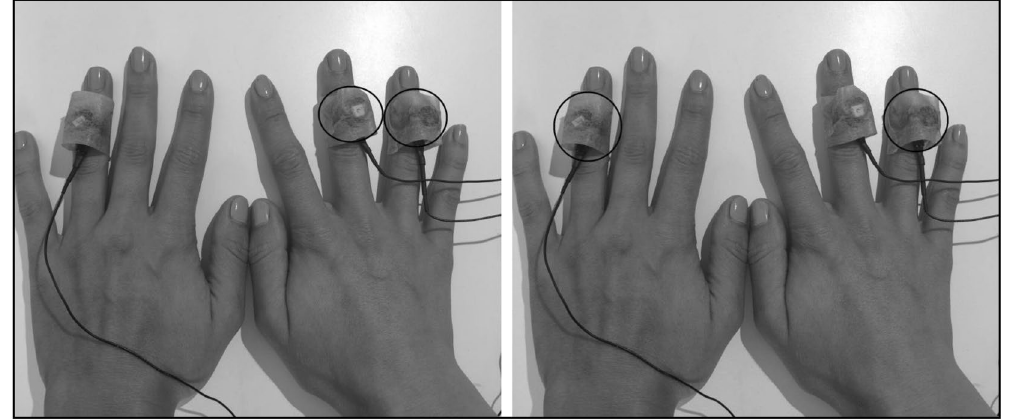
Figure 5. Illustration of the experimental setup. Active stimulators in the respective condition are circled in black. The left part shows the within-hand condition, the right part the between-hands condition. In the within- hand condition, GO and NOGO stimuli are simultaneously delivered to the ring and middle finger of the right hand. In the between-hands condition, the ring fingers of both hands were simultaneously stimulated using GO and NOGO